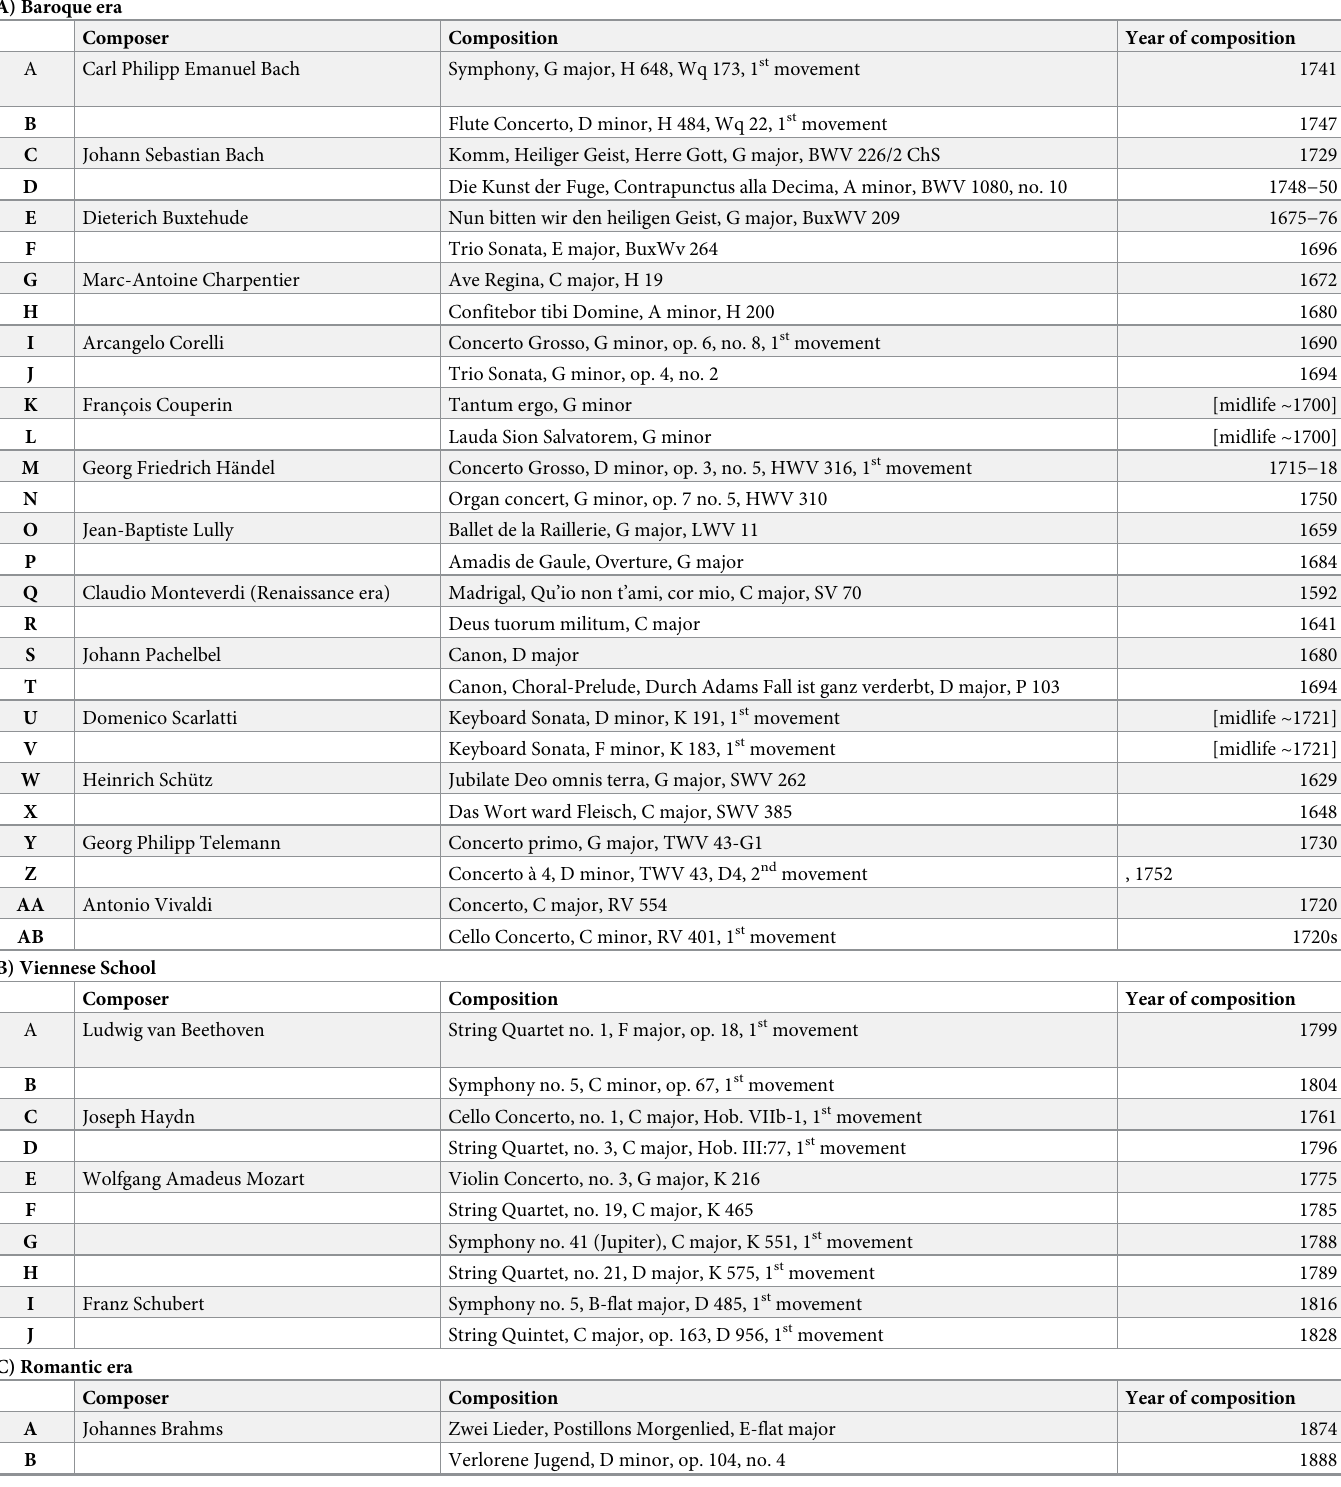
Table 1. A, B, C. Examples of music compositional works from the Baroque era, the Viennese School and the Romantic era used for fingerprinting and the genera- tion of quasi-phylogenies. [First 20 bars (without upbeat) of the first movement considered]. A) Baroque